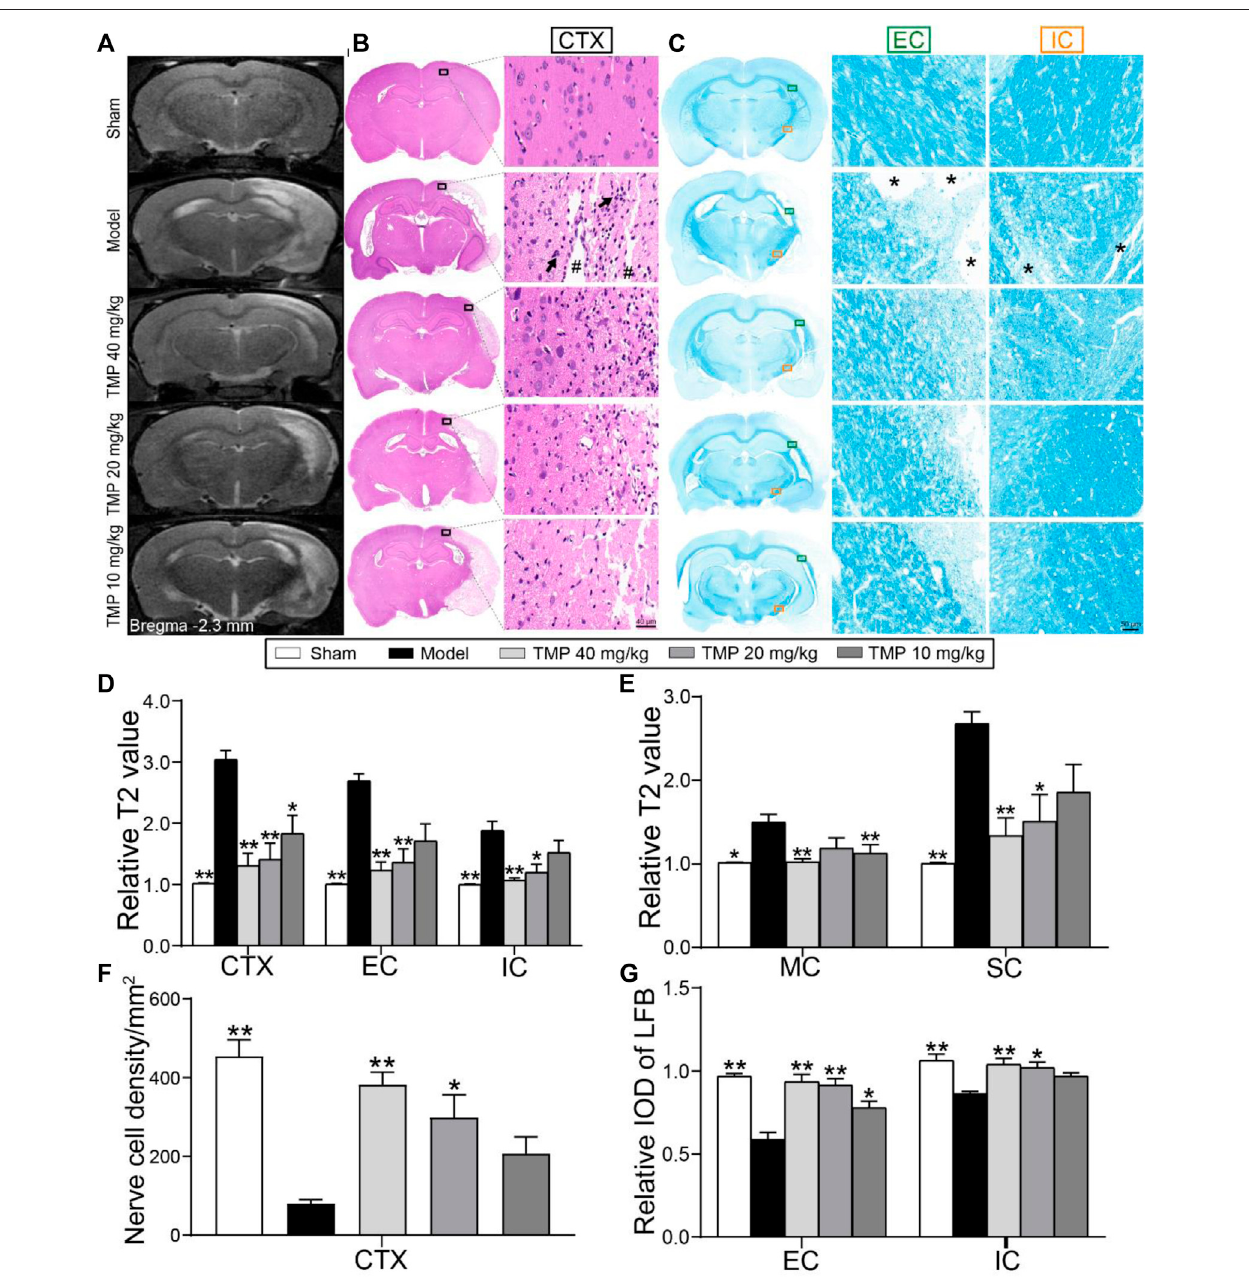
FIGURE 2 | Effect of TMP on cerebral tissue injury in MCAO rats. (A) Typical T2 relaxometry mapping of each group ( n = 6). (B) Typical HE staining photographs showed the degeneration and necrosis of the nerve cells (black arrows) in the peri-infarct cortex (CTX, black boxes) and destructive tissues (#) indicated in the model group( n =4). (C) TypicalLFBstainingphotographsshowedmyelinsheathoftheexternalcapsule(EC,greenboxes)andinternalcapsule(IC,orangeboxes).Remarkable cavitationareaswithmyelinsheathloss(*)innerve fi berswereindicatedinthemodelgroup(n=4).QuantitativeanalysisofrelativeT2valuesof (D) CTX,EC,andIC, (E) motorcortex(MC),andsomatosensorycortex(SC).Quantitativeanalysisof (F) thenervecelldensityofCTXand (G) relativeLFB-IODofECandIC.* p < 0.05and** p < 0.01 vs. Model group.